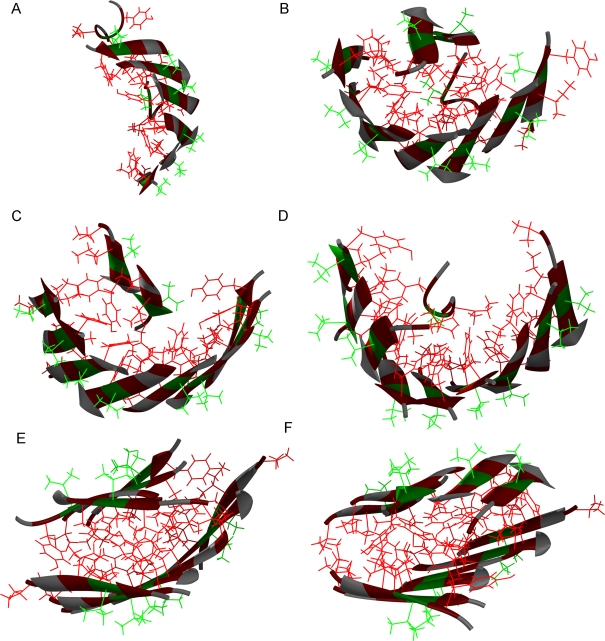
Six snapshots from the aggregated phase of the 12-chain run at low concentration (side length 80 Å).The snapshots (a)–(f) were taken after 67, 68, 71, 86, 91 and 96 steps, respectively. Side-chain colors are as in Figure 2. (a) A six-stranded β-sheet in contact with two random coils. (b) Two β-sheets with seven and two chains, respectively, and a random coil. (c) One eight- and one two-stranded β-sheet. (d) A nine-stranded β-sheet and a 310-helix. (e) One six- and one four-stranded β-sheet. (f) The same sheets as in (e) but with a different relative orientation.